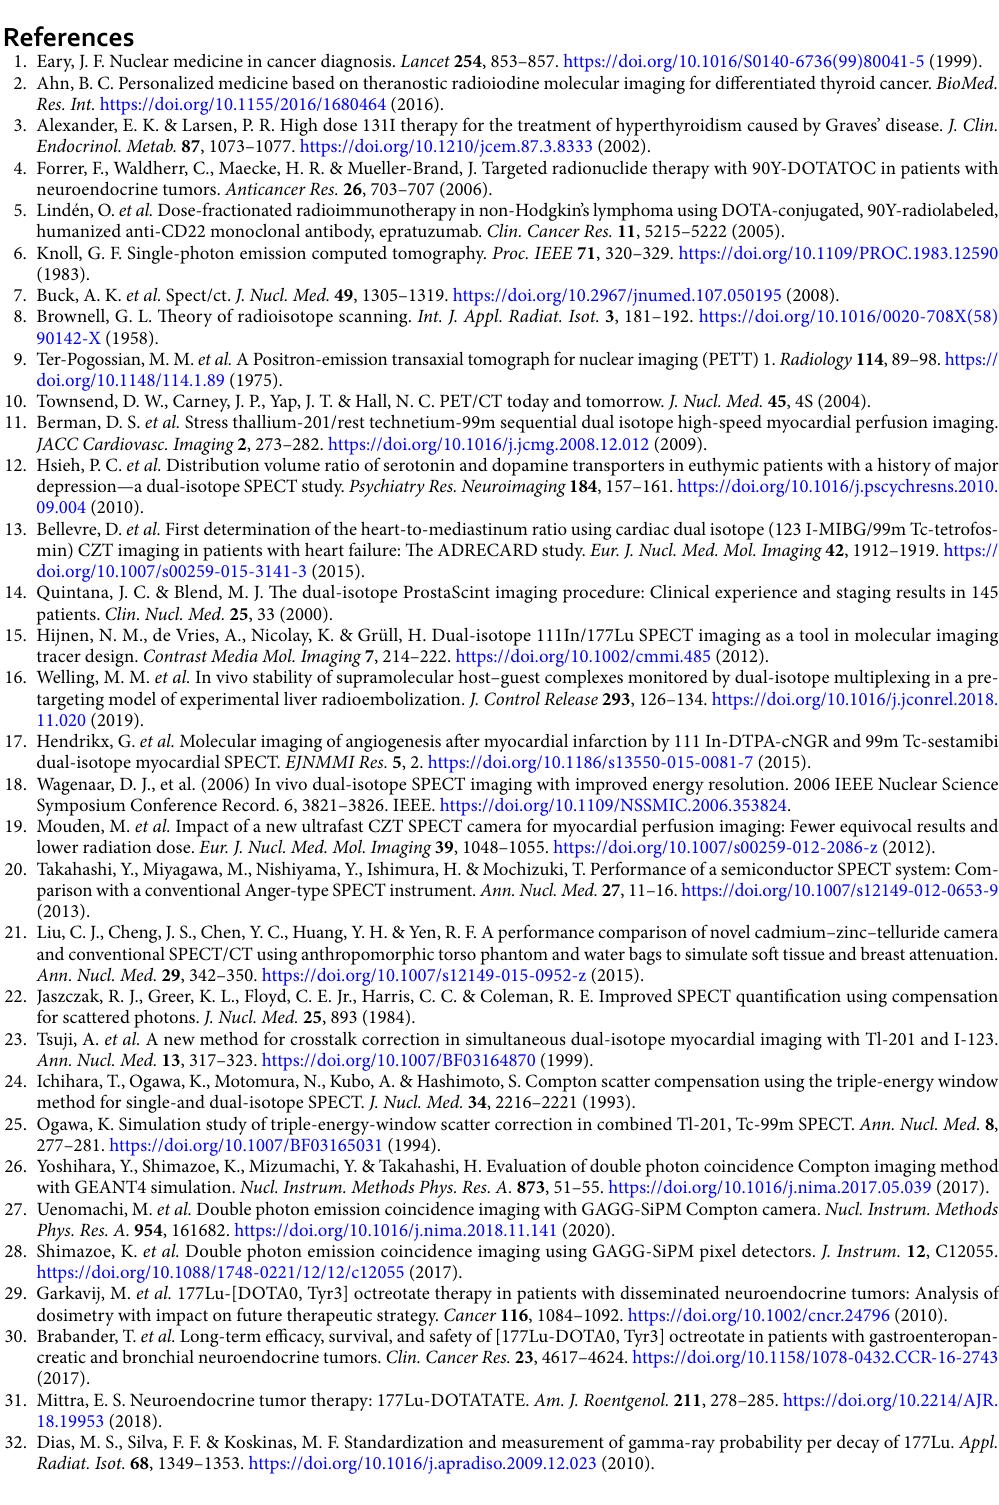
depict the 1D plots normalized as 1. The background is shown as dot lines. The SBRs in the x - and y -axis are calculated as follows: